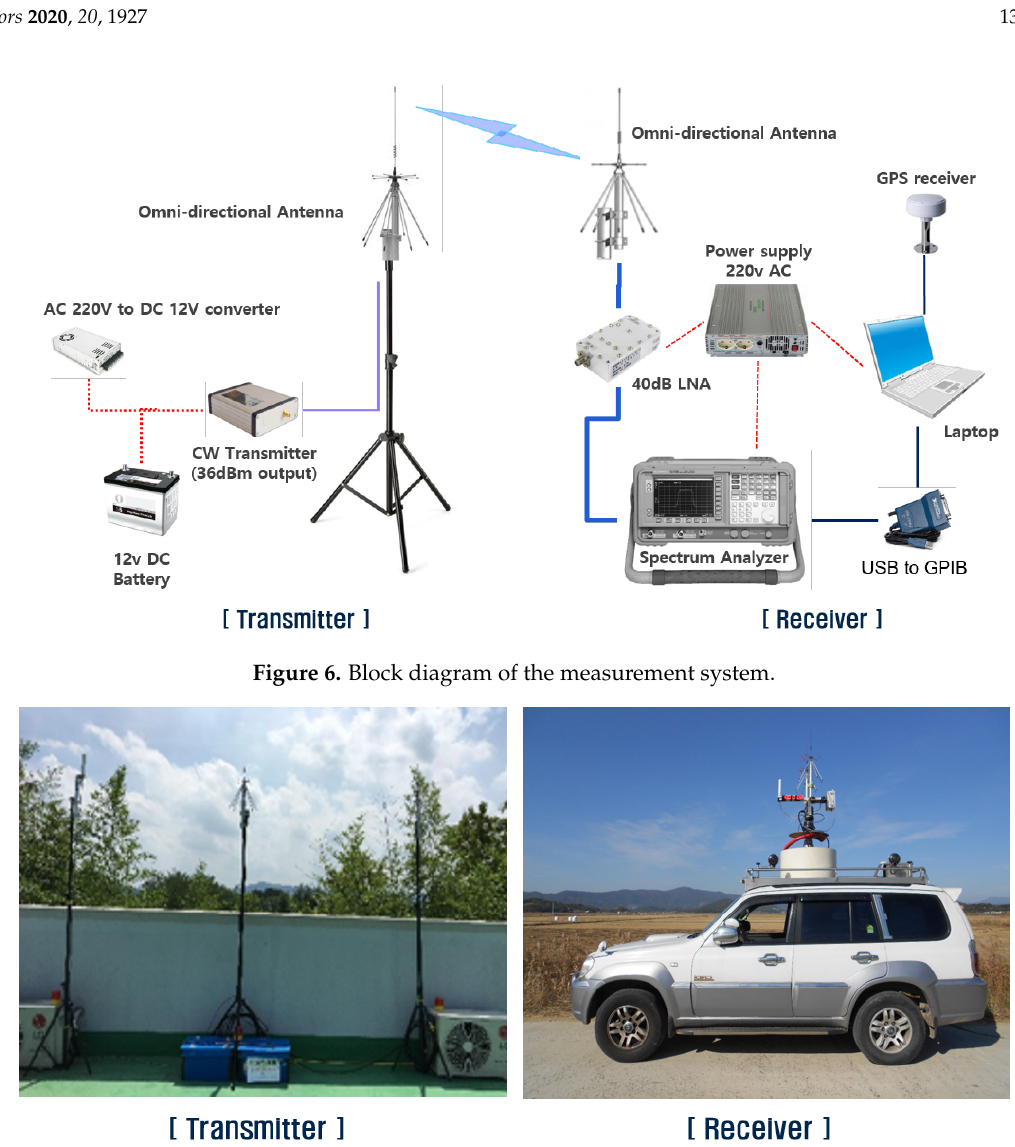
Figure 7. Installation environment of the measurement